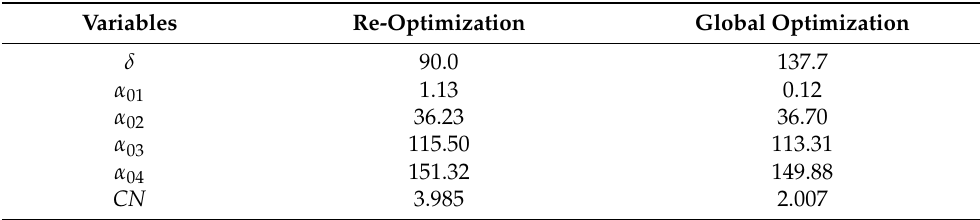
Table 1. Optimized retardance and nominal angles of the used retarder under the suggested maxi- mum exposure angle of 30 ◦ in a time-integration imaging polarimeter (unit: ◦